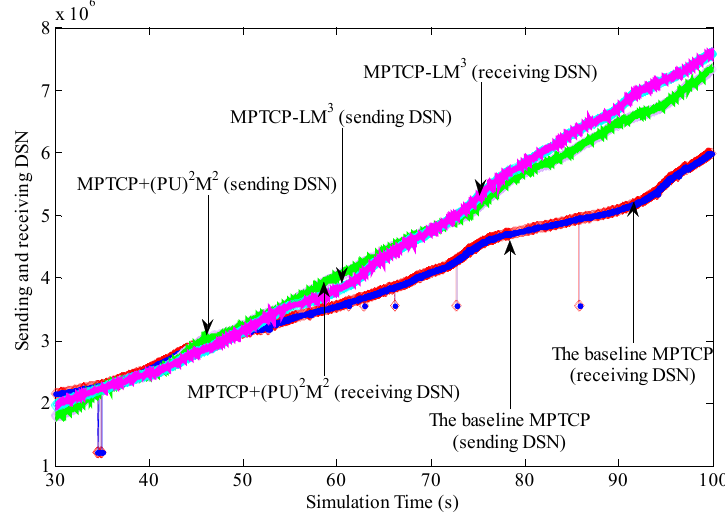
Figure 8. The comparison of data sending and receiving